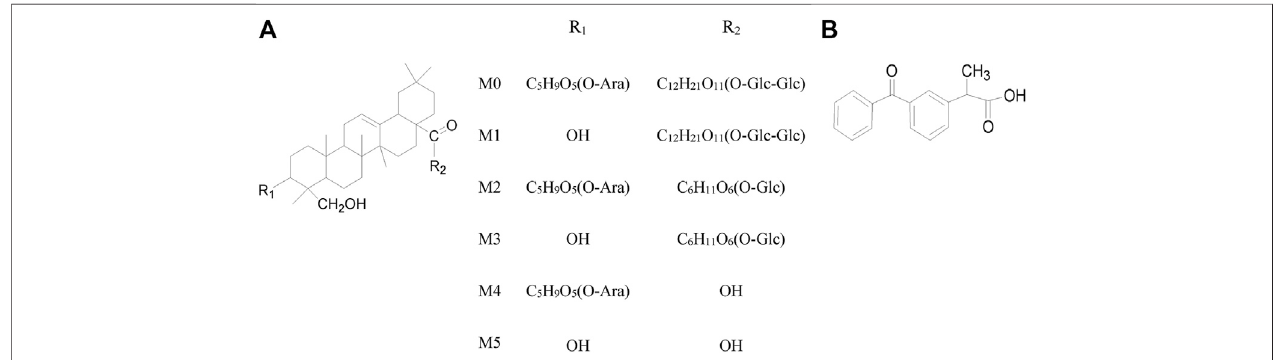
FIGURE 1 | (A) Chemical structure of ASD and fi ve metabolites (B) Dexketoprofen (IS).